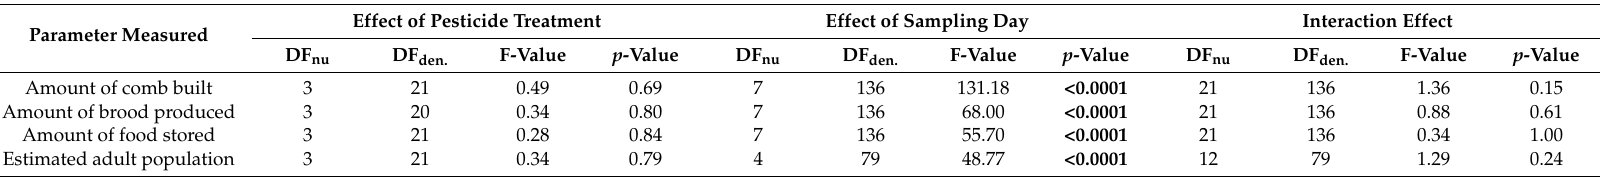
Figure 2. Estimated adult population for each of the 30 new honey bee colonies established on 18 May 2017 (day 0). There were seven colonies in the amitraz treatment group, seven in the chlorothalonil and chlorpyrifos treatment group (“C+C”), seven in the tau ‐ fluvalinate and coumaphos treatment group (“F+C”), and nine in the control group. Each colony was started with an artificial swarm containing 3 lbs of adult bees, or approximately 10,476 individuals [18]. Population size was estimated every six weeks through 17 October 2017 (day 146) for a total of four sampling periods. Data are presented as the mean ± S.E.M. Table 1. Statistical values for repeated measures analysis of variance (ANOVA) tests performed for each of the four variables of colony growth assessed from new honey bee colonies established in 2017. There was a significant effect of sampling day for all variables. However, there was neither a significant effect of pesticide treatment group (i.e., amitraz alone, a mix of chlorothalonil and chlorpyrifos, or a mix of tau ‐ fluvalinate and coumaphos), nor an interaction effect between pesticide treatment group and sampling day on any of the variables measured. Significant statistical values are shown in bold.